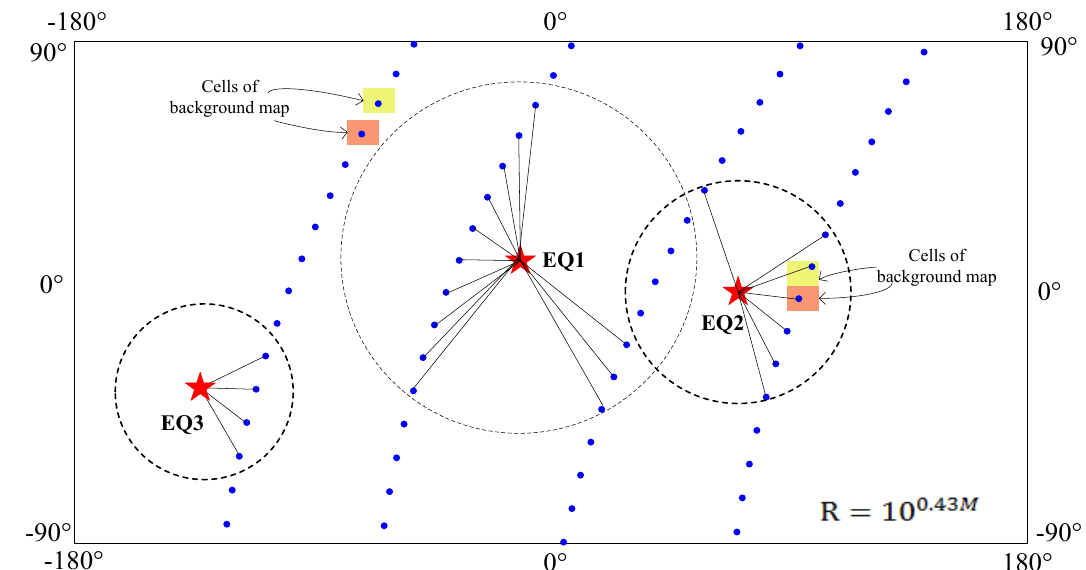
Figure 2. Sketch map showing the datapoints on the orbit (blue dots), earthquake epicenters (red star), and the areas of Dobrovolsky’s radius R around epicenters (dashed circles). Datapoints only used for one earthquake (with mark = 1) are connected to the epicenter by black lines. The radius of the circles is not at the scale of the map.